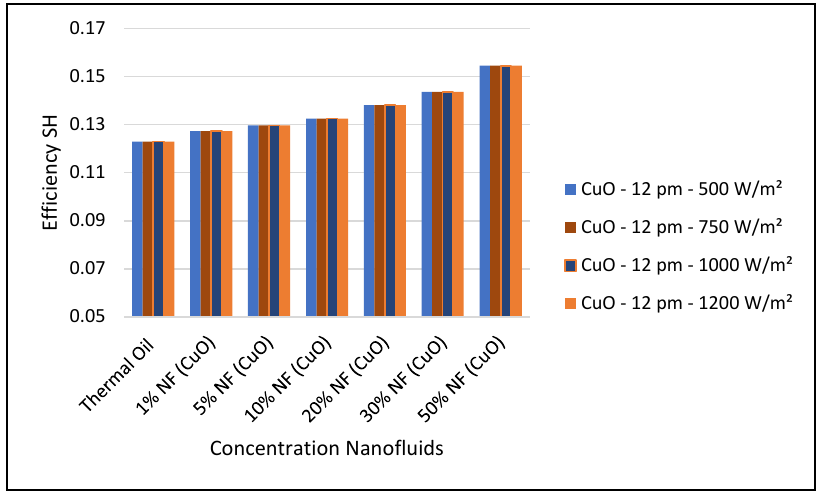
Figure 30. CSP system hybrid ORC work at CuO nanofluid and different concentrations.